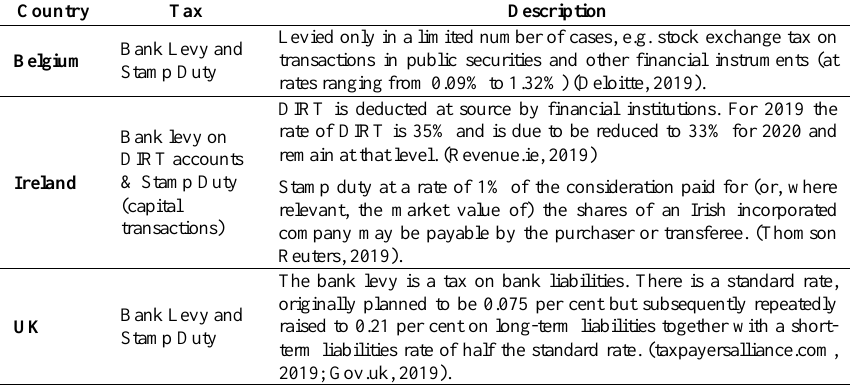
Table 2. Brief description of financial transaction taxes in selected EU countries